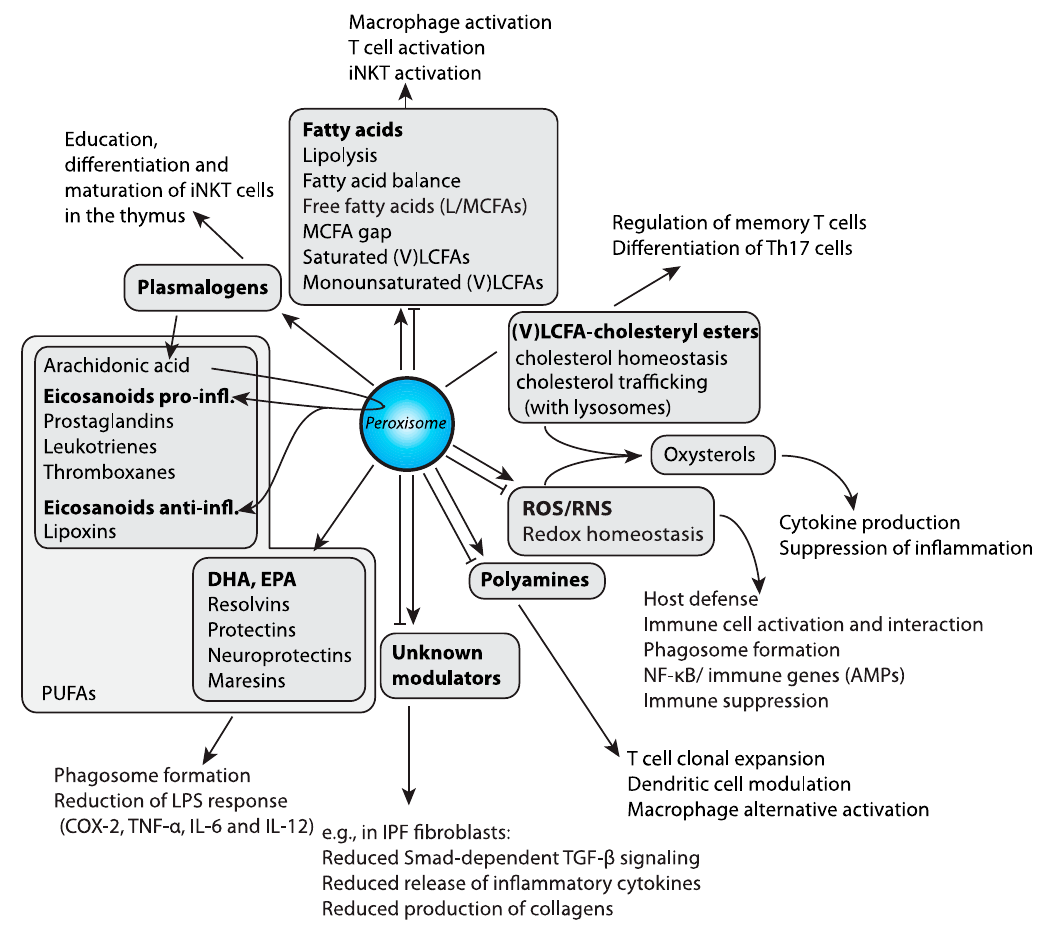
Figure 1. Peroxisomal metabolites and immunity. The metabolites influenced by peroxisomal function (in bold) with downstream processes or derived metabolites (listed in grey boxes) with examples of their roles in the immune system activation and regulation are depicted. Peroxisomal β -oxidation is both involved in the degradation and synthesis of polyunsaturated fatty acids (PUFAs). Moreover, peroxisomes are needed for the production of plasmalogens (ether lipids), which in turn are a source for PUFAs. Arachidonic acid is used for the production of eicosanoids with proinflammatory (prostaglandins, leukotrienes, thromboxanes) or anti-inflammatory functions (lipoxins). Docosahexaenoic acid (DHA) and eicosapentaenoic acid (EPA) serve as precursors for resolvins, protectins, and maresins, which are important for the resolution of inflammation. Furthermore, peroxisomes are needed for the regulation of overall fatty acid composition by degrading very long-chain fatty acids (VLCFAs) and regulating the catabolism of LCFAs / MCFAs. Additionally, peroxisomes are involved in cholesterol homeostasis, intracellular trafficking of cholesterol, and the balance of free and esterified cholesterol. Oxysterols, formed through enzymatic or non-enzymatic cholesterol oxidation, are impacted by the redox balance in the cell, which depends on peroxisomal function. Peroxisomes are involved in the degradation and production of polyamines and might play a role in the degradation and production of other yet unknown modulators of the immune